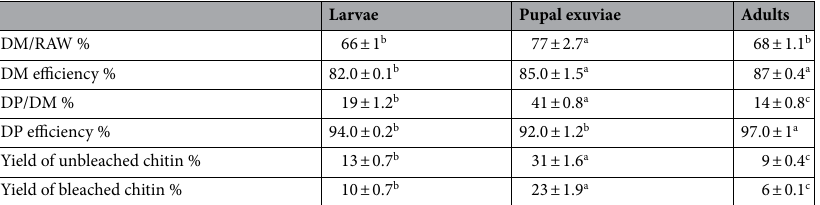
Table 2. Biomass recovery (%) from larvae, pupal exuviae and dead adults after demineralization (DM/RAW) and deproteinization (DP/DM), efficiency (%) of DM and DP, and yields (%) of unbleached and bleached chitin related to the original raw insect biomass. Data are expressed as mean ± standard deviation . Different letters in a row indicate significant differences in the percentage of chitin recovery, DM and DP efficiency and yield among the different insect samples ( p < 0.05) (data analyzed with one-way ANOVA and Tuckey post-hoc